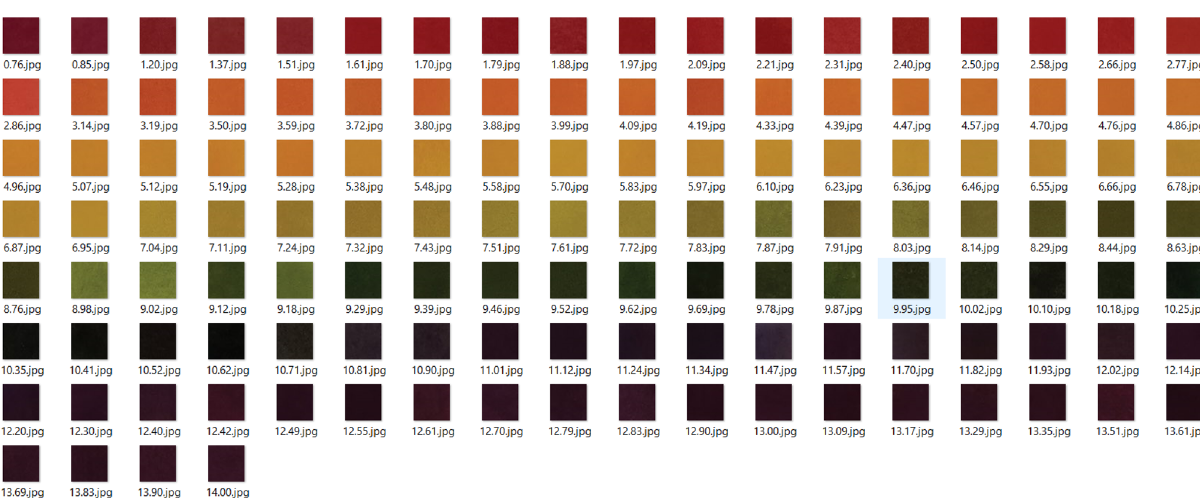
Figure 2. Samples of the captures of an experimentally colored change of the pH-paper at 350